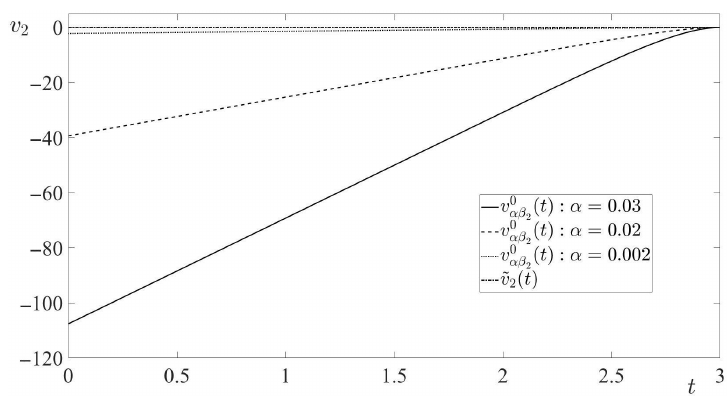
( t ) and limiting function ˜ v αβ 2 ( t ) is depicted in Figure 9 as a function of α . It is seen that it 0 , z 0 αβ